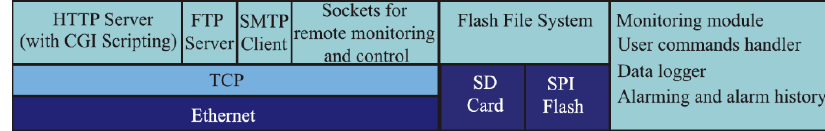
Figure 15. Functionalities of the Ethernet gateway module (HTTP-Hypertext Transfer Protocol, CGI-Common Gateway Interface, FTP-File Transfer Protocol, SMTP-Simple Mail Transfer Protocol, SPI-Serial Peripheral Interface, TCP-Transmission Control Protocol) [15].